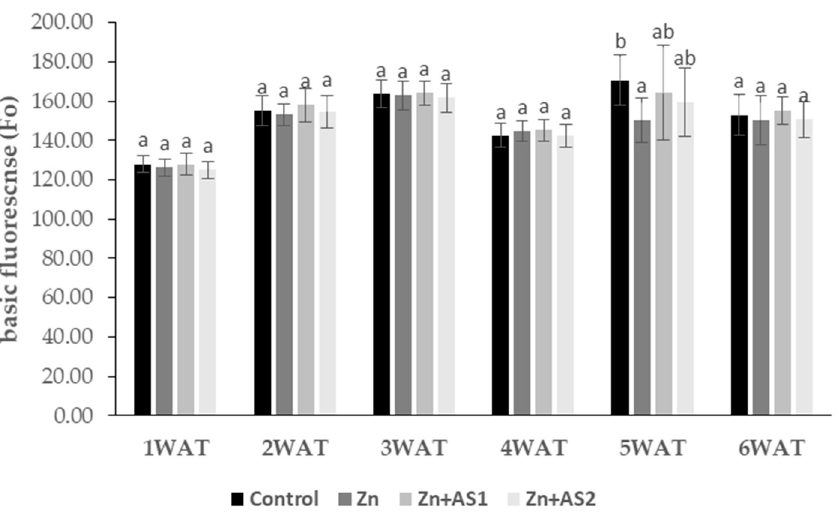
Figure 2. The effect of different foliar treatments (Zn, Zn+AS1, and Zn+AS2) on the basic fluorescence (F o ) in the second youngest and fully developed leaves of maize 1, 2, 3, 4, 5, and 6 WAT. n = 20 ± S.D. Lower case letters (a, b) show the significant differences among the treatment based on sampling time. WAT: week(s) after